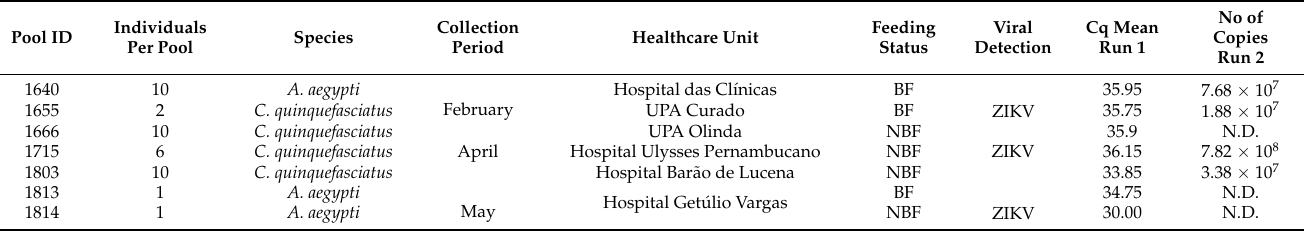
Table 3. Detailed characteristics from mosquito pools with detectable viral RNA loads from health care units from the metropolitan area of Recife